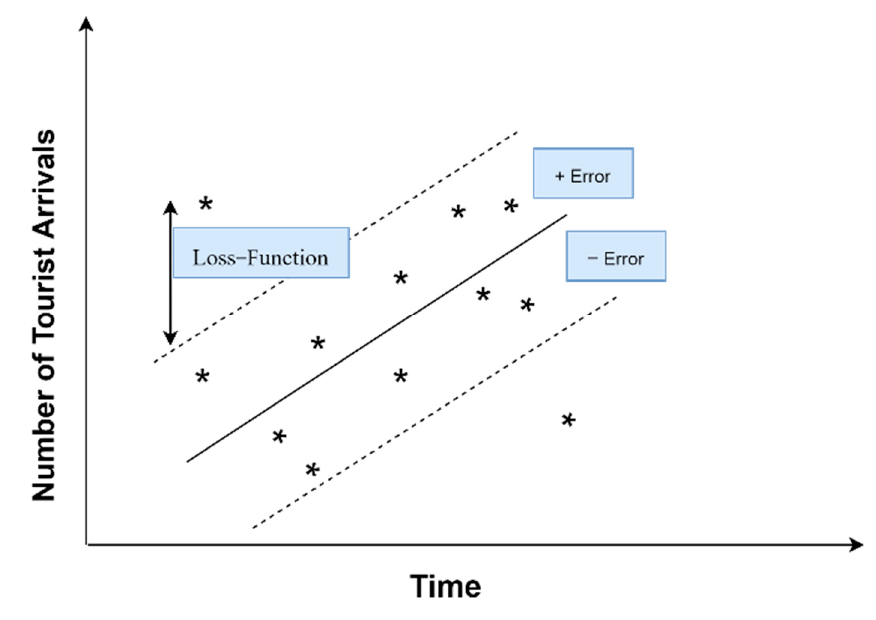
Figure 1. Graphical representation of the support vector regression. *, Training data points. Source: Authors own elaboration.